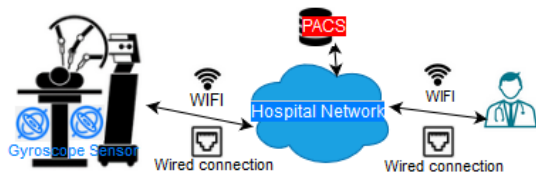
Figure 6. Robotic